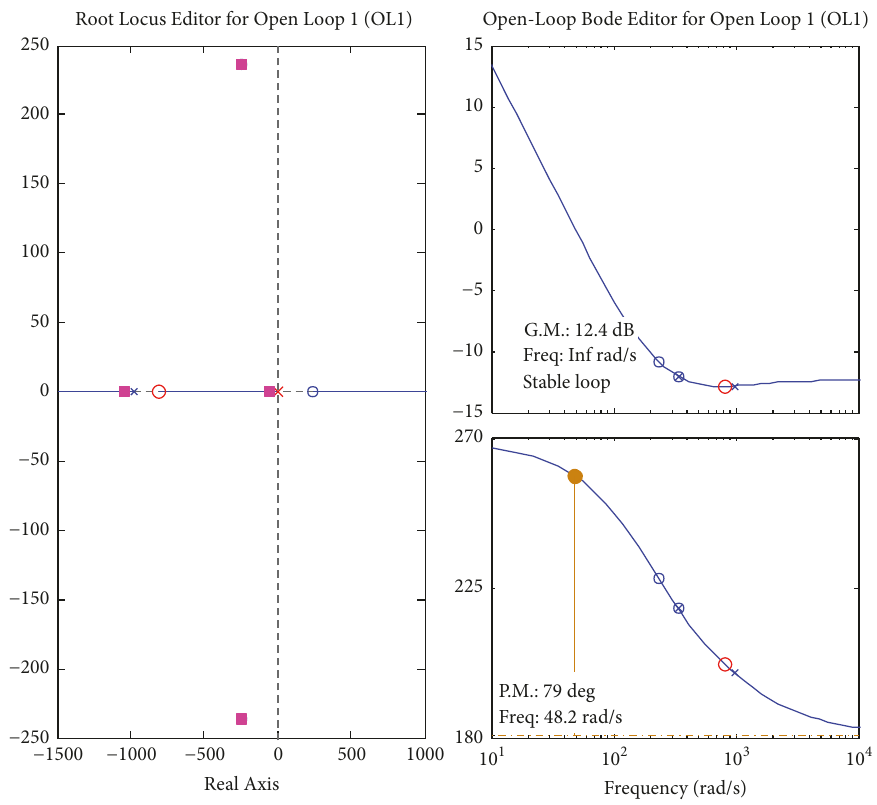
Figure 6: Root locus and open loop bode plots for the outer loop of boost